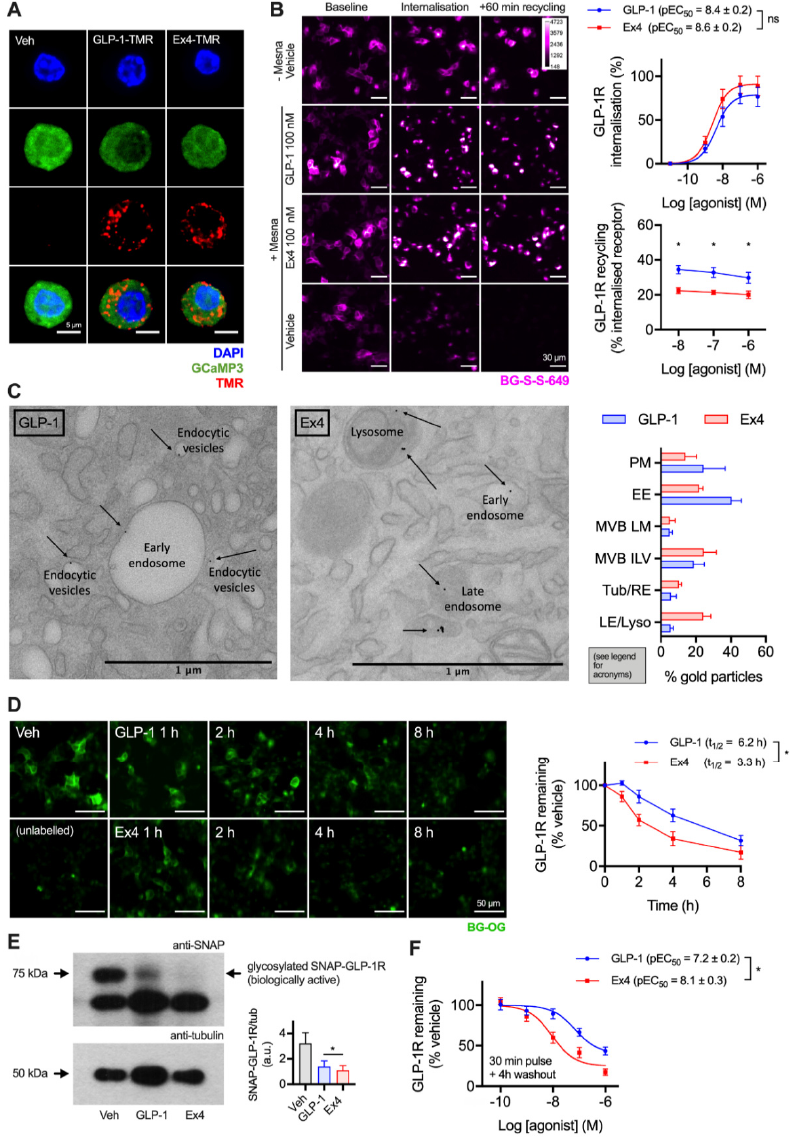
Figure 1. Accelerated GLP-1R degradation with exendin-4 in beta cells. ( A ) Endocytic uptake of 100 nM GLP-1-TMR or exendin-4-TMR in GLP-1R-expressing dispersed primary islet cells. GLP-1R- positive cells are marked by GCaMP3 under GLP-1R promoter-driven Cre expression. Representative images from n = 2 mice. Scale bar = 6 µm. The sequences and pharmacological characterisation of GLP-1-TMR and exendin-4-TMR are provided in the Supporting Information (Supplementary Figure S1). ( B ) Assessment of GLP-1R trafficking in INS-1-SNAP-GLP-1R cells using high content microscopy. Representative images and quantification of GLP-1R internalisation (30 min) and recycling (60 min) from n = 5 experiments is shown, with internalisation pEC 50 compared by paired t - test, and recycling results compared by two-way randomised block ANOVA with Sidak’s test. Scale